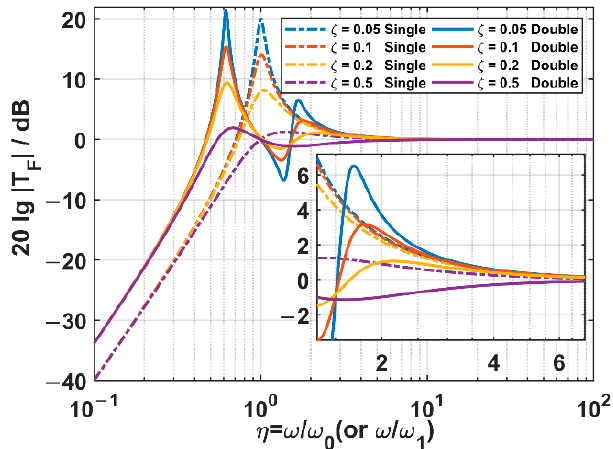
Figure 9. The acceleration response spectra of the FOVHs in two suspension systems in different damping ratio cases. Among them, the dashed lines are the results of the OSSS, while the solid lines are those of the TSSS.